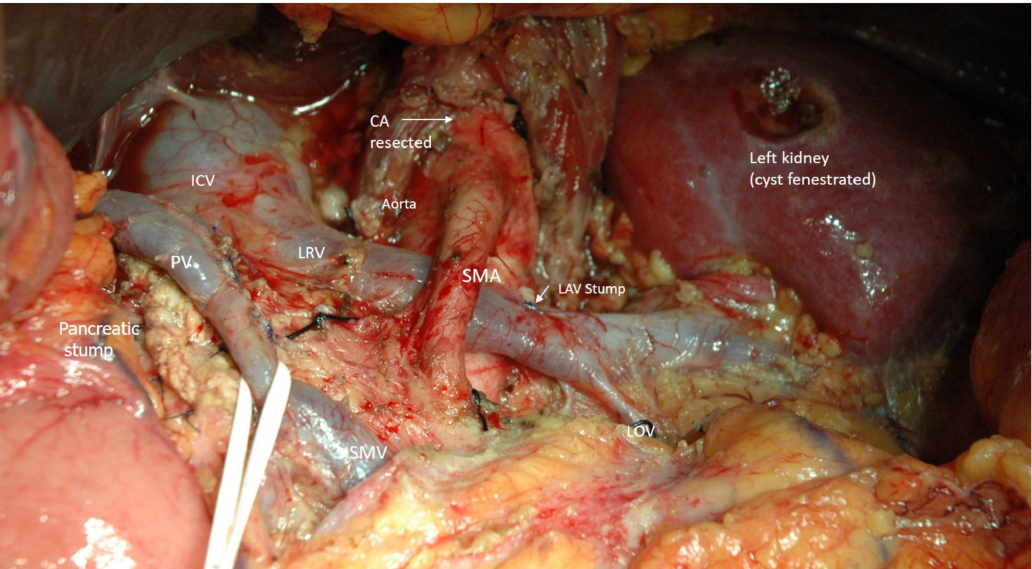
Figure 1. Intraoperative photo. Typical view of the operating field after R0 posterior RAMPS with celiac (CA) and left gastric arteries resection without arterial reconstruction. Explanations in the text. SMA- superior mesenteric artery, PV—portal, SMV—superior mesenteric, LRV—left renal, LAV—left adrenal, LOV—left ovarian veins, ICV—inferior vena